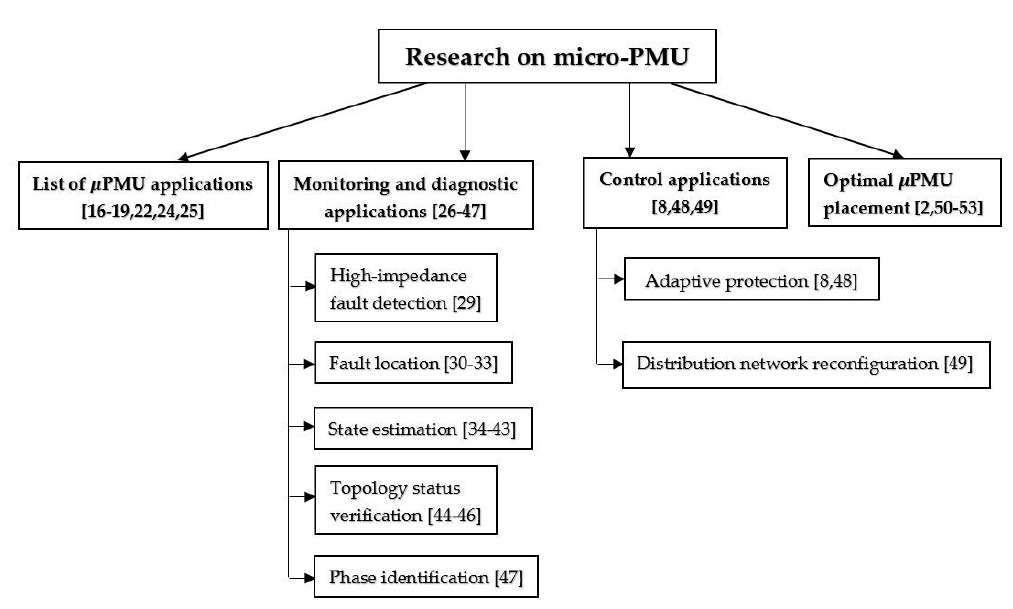
Figure 3. µ PMU with related